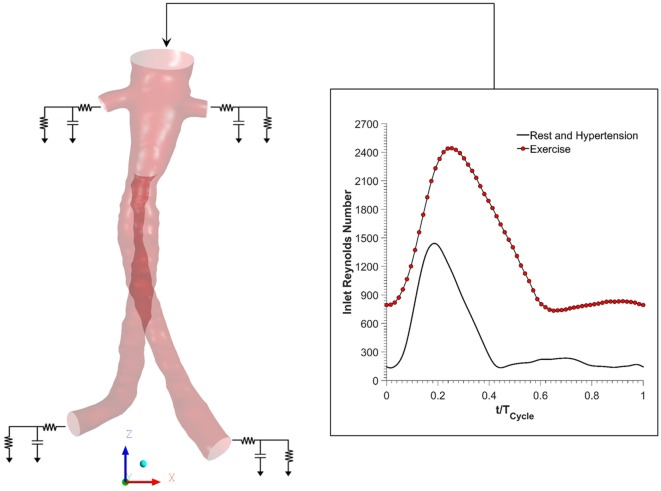
Schematic of the numerical model used in the study. Volumetric flow rate was imposed at the inlet, and this inflow waveform was adjusted accordingly for resting, hypertension, and exercise scenarios. No slip boundary conditions were imposed at the fenestrated stent graft walls, which were assumed to be rigid. Outlet pressure waveforms were obtained by coupling each outlet with a 3-element Windkessel model (3-EWM). Hypertension and hypertension plus exercise simulations were simulated by appropriately adjusting the parameters of the 3-EWM.